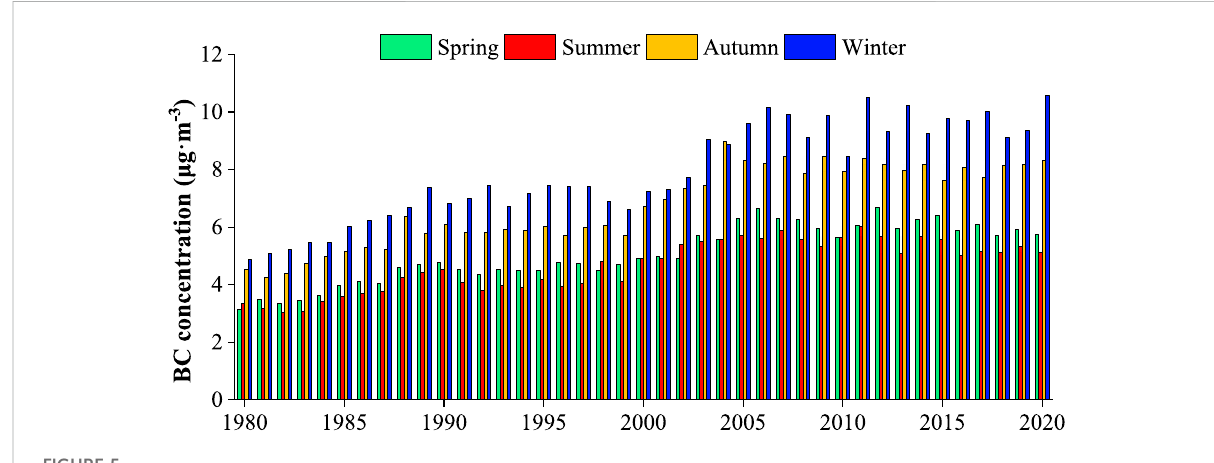
FIGURE 5 Seasonal variation in BC concentrations from MERRA-2 data in Zhengzhou from 1980 to 2020.